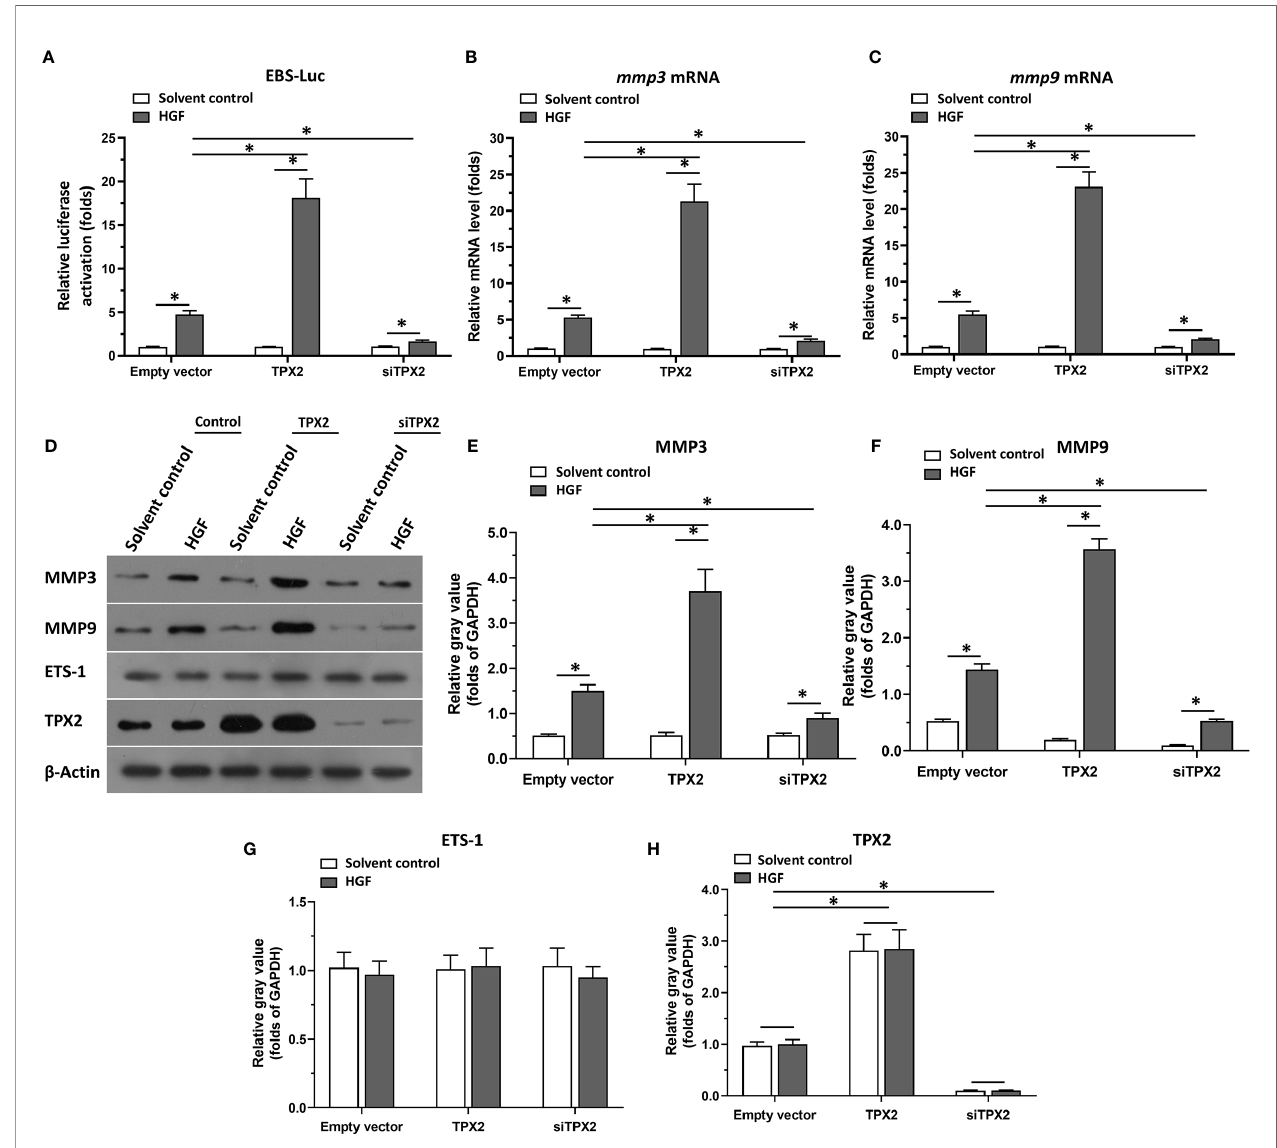
FIGURE 1 | TPX2 enhanced the transcription factor activation of ETS-1. Cells were treated with the solvent control or 10ng/ml concentration of HGF. PC-3 cells which were co-transfected with luciferase reporter (EBS-Luc) and the control, TPX2 or siTPX2, were harvested for luciferase analysis (A) . (B, C) PC-3 cells which were transfected with the control, TPX2 or siTPX2, were harvested for qPCR to examine the mRNA level of mmp3 (B) or mmp9 (C) . (D – H) The expression of TPX2, MMP3 or MMP9 in PC-3 cells were examined by western blot. The results were shown as western blot images (D) or the quantitative results of the western blot (E – H) .